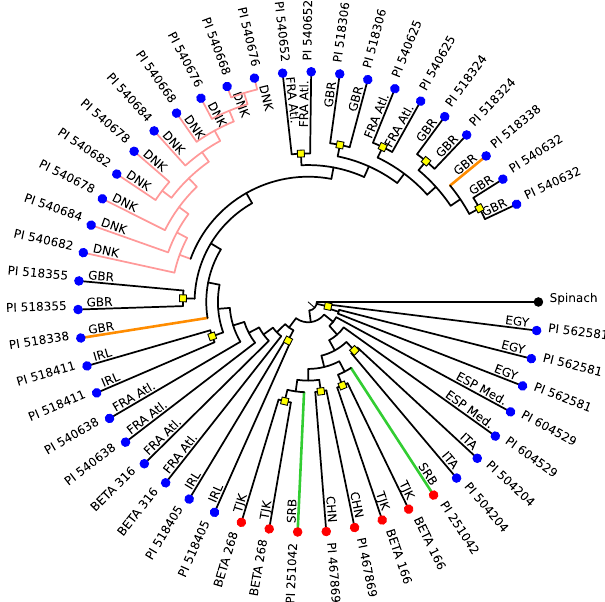
Fig. 2 Phylogenetic tree of 23 Beta accessions and spinach as outgroup based on Mash distances calculated from whole-genome Illumina sequencing data. The 47 samples represent 23 Beta accessions. Pairwise clustering according to their accession identi fi ers is indicated by highlighting the respective nodes with a yellow square, discordant clustering is indicated by colored branches. Country designations are given at each branch, species designations are re fl ected in the leaf colors (red: B. v. vulgaris , blue: B. v. maritima , black: outgroup, Med.: Mediterranean, Atl: Atlantic). Source data are provided as a Source Data fi